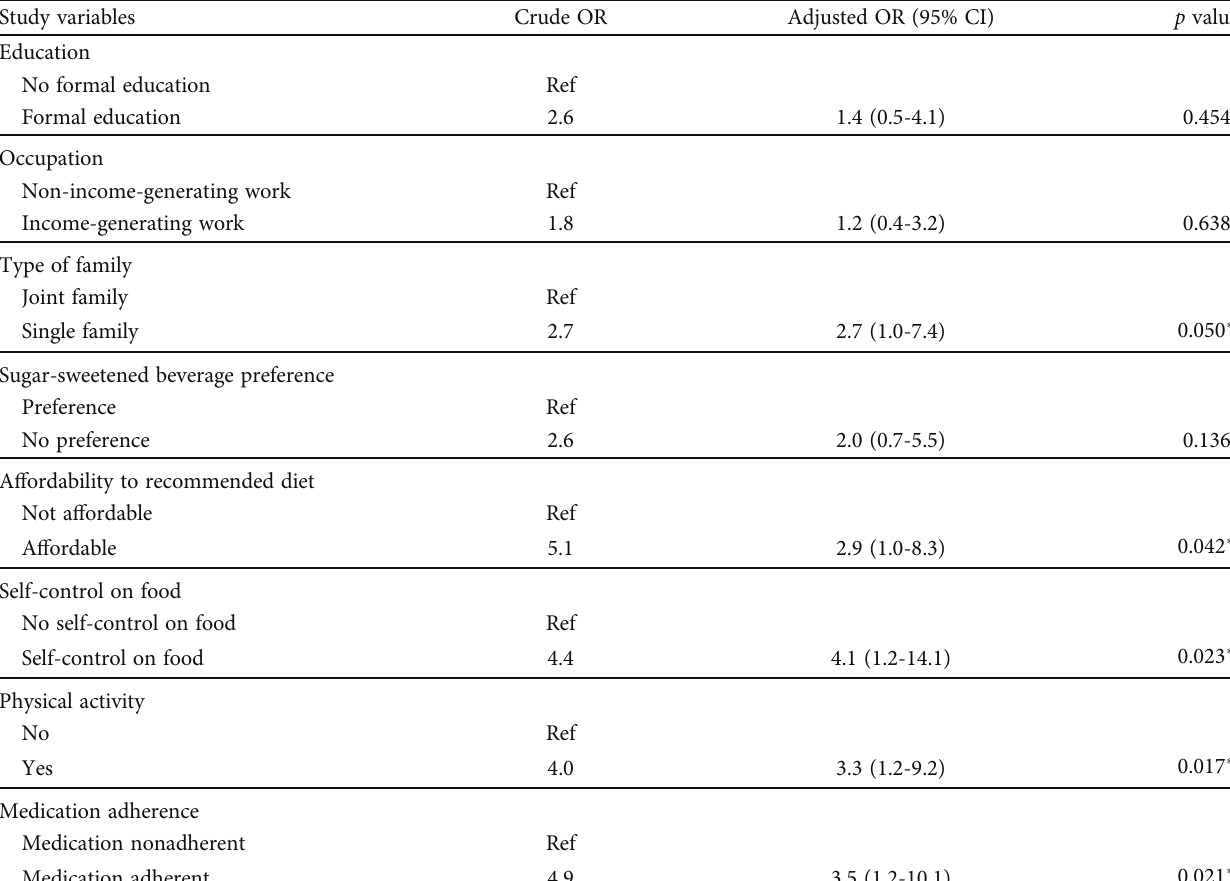
Table 3: Factors associated with dietary